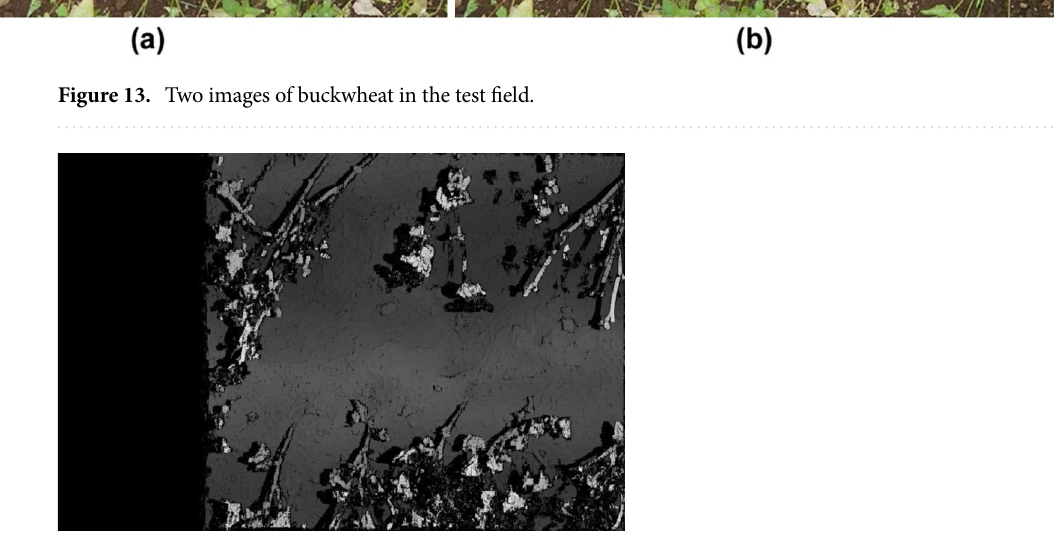
Figure 14. Disparity map obtained from the two images shown in Fig. 13.